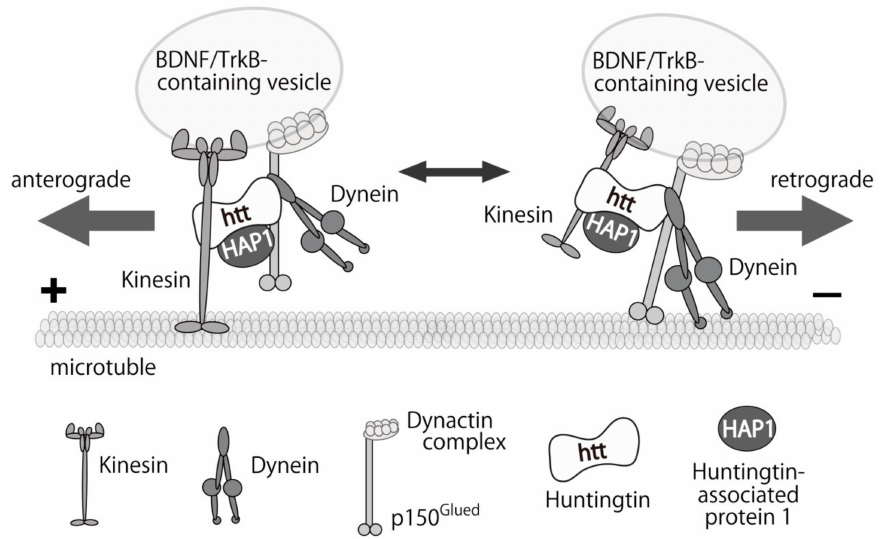
Figure 2. A proposed model of the bi-directional transport of BDNF/TrkB-containing vesicle on microtubules. The motor complex includes the motor proteins, huntingtin, huntingtin-associated protein 1 (HAP1), and dynactin complex. It can involve both kinesin and dynein simultaneously that are responsible for the anterograde (towards to the plus-end of microtubule) and the retrograde (to the minus-end) transport of cargos, respectively. Phosphorylation of huntingtin at serine 421 is possible to regulate the direction of transport, by stabilizing kinesin at the complex and dominantly move to the plus-end. Dynein-dependent retrograde transport becomes dominant when huntingtin is dephosphorylated (See also [166]). Because impaired intracellular transport of BDNF/TrkB-containing vesicles has been suggested as pathophysiology of neurodegenerative diseases, ameliorating the impairment would be a potential therapeutic target for the future medical treatment. +: plus end; -: minus